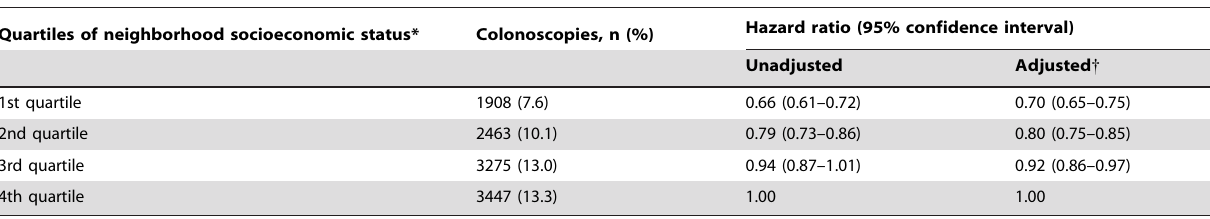
Table 3. Association between neighborhood poverty and use of screening colonoscopy, 2000–2007.